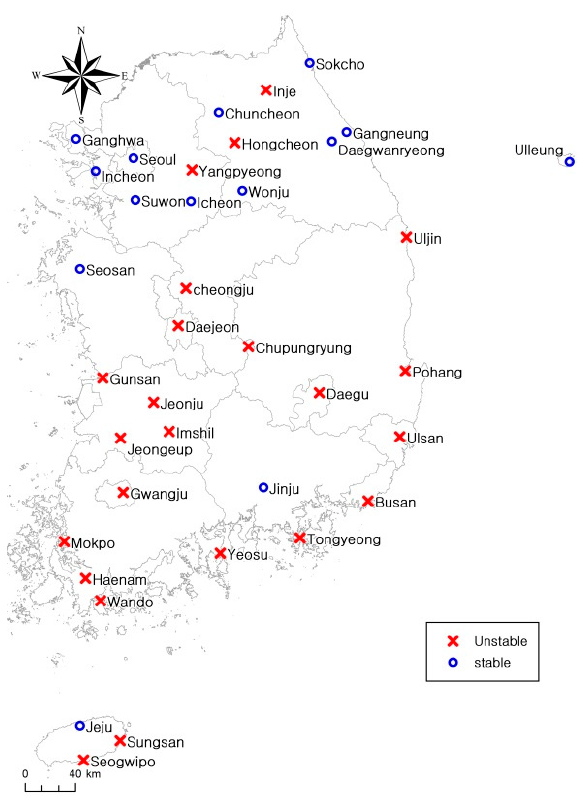
Figure 12. Stability test results.